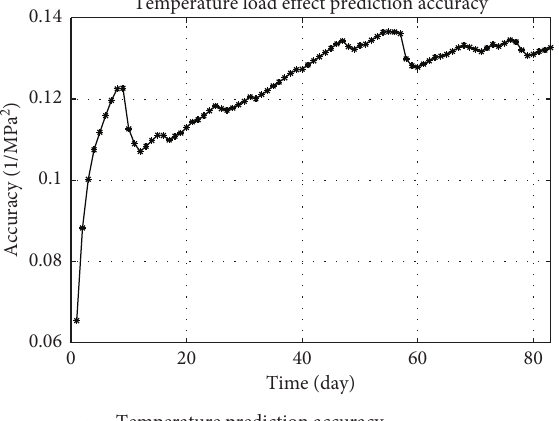
Figure 5: Prediction precision of temperature load